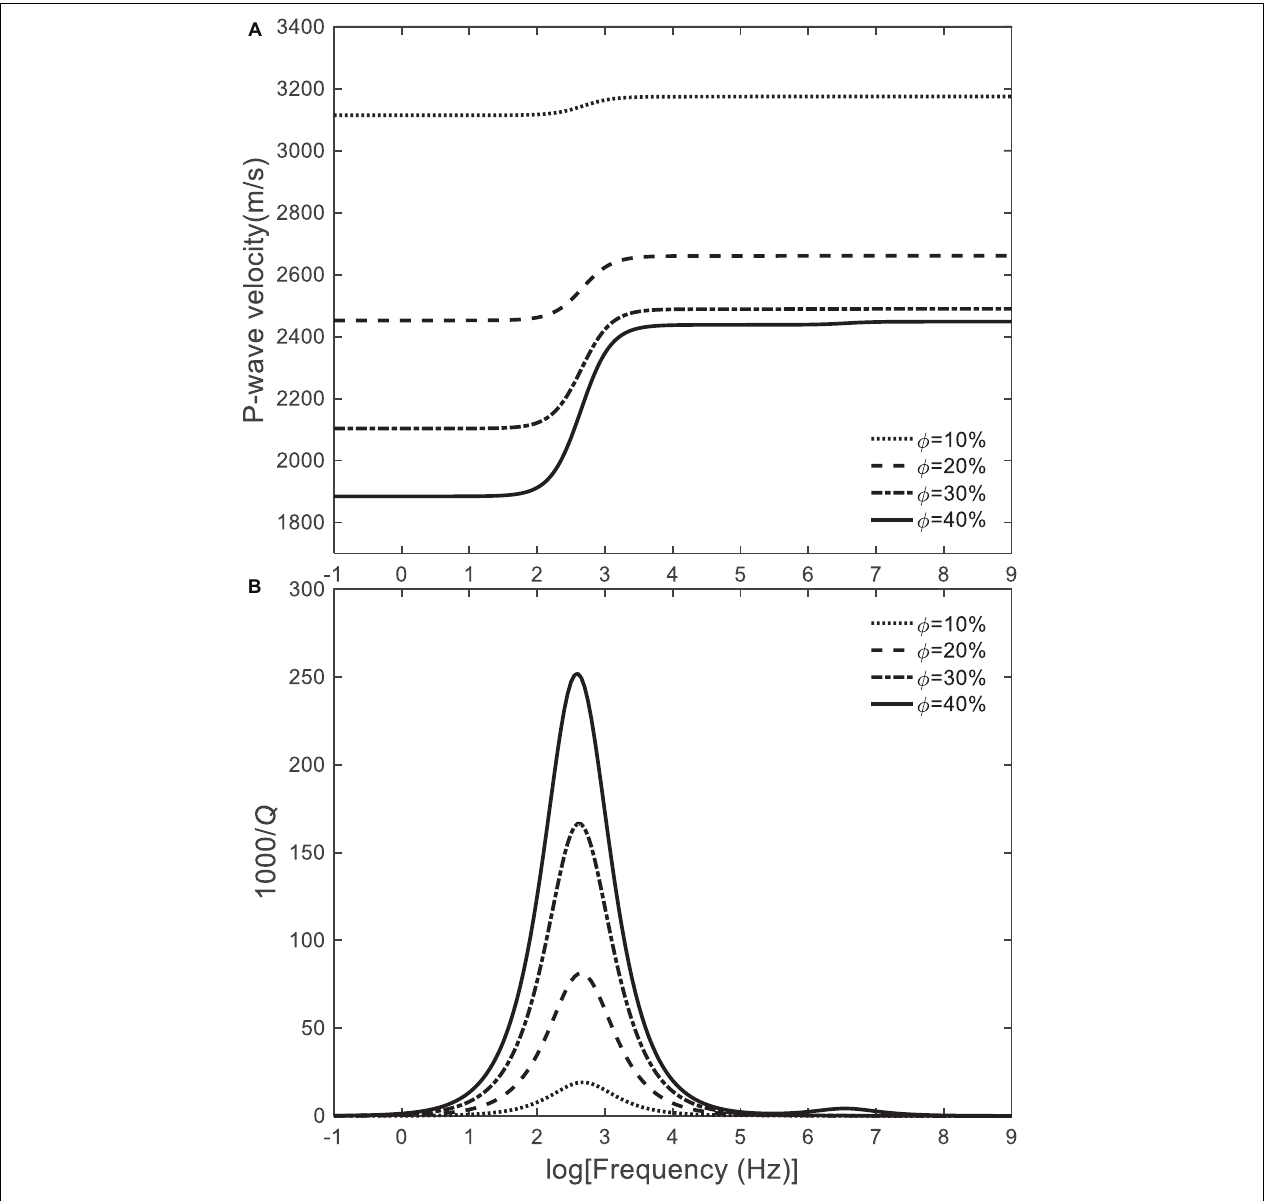
FIGURE 9 | Model 2. P-wave velocity (A) and dissipation factor (B) as a function of frequency for different rock porosities. The inclusion radius is 1 cm, and hydrate concentration is